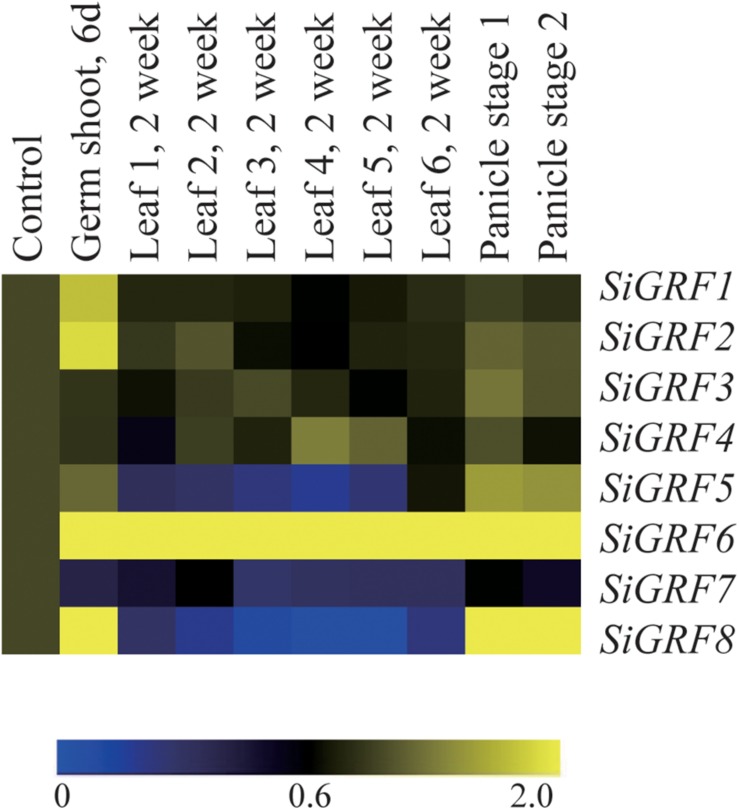
Tissue-specific expression of foxtail millet SiGRF genes in four major tissues: shoot (control), germ shoot, leaf, and panicle (two stages). The color scale representing the log of signal values is shown below the expression profiles.